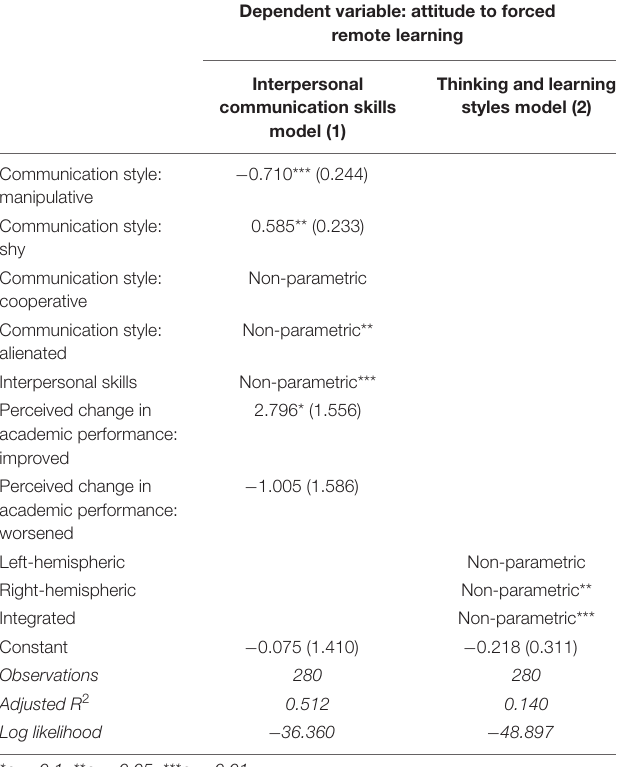
TABLE 2 | Generalized additive